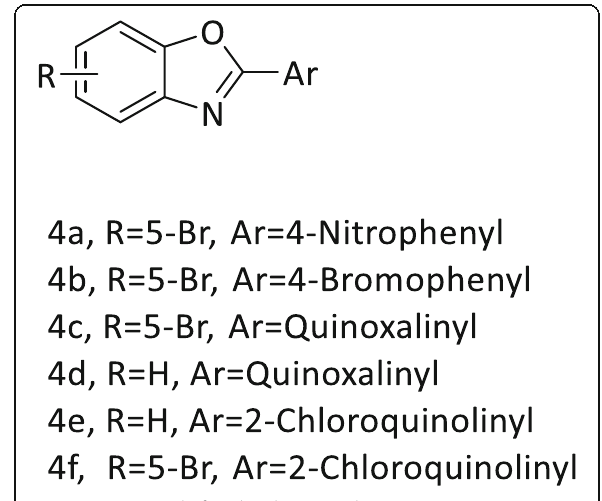
Fig. 26 Benzoxazole fused with quinoxalin Fig. 27 VEGFR-2 inhibition